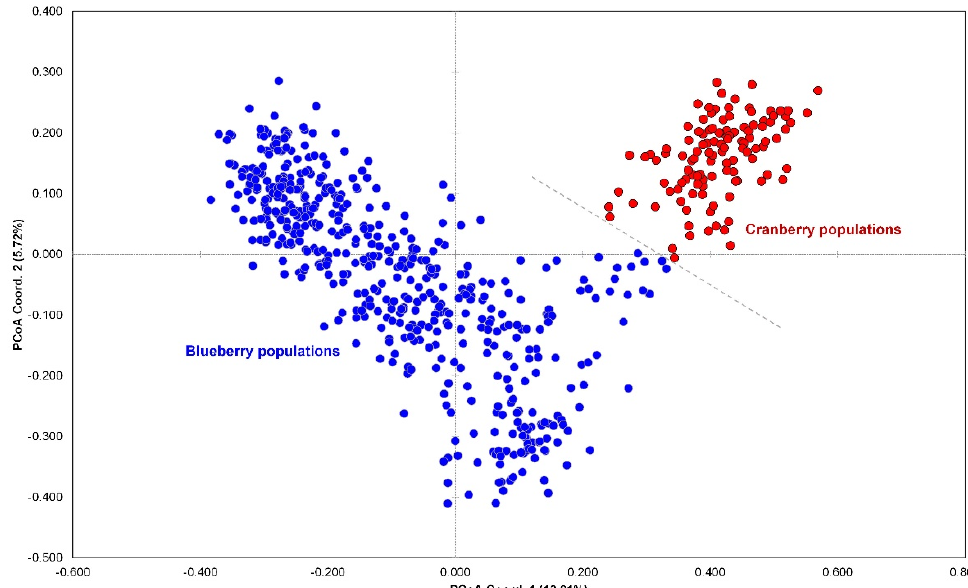
Figure 2. Principal coordinate analysis (PCoA) plotted using microsatellite data from 632 Dasineura oxycoccana individuals collected from 31 blueberry and cranberry populations from USA and Korea. The X-axis is coordinate 1, ranging from − 0.60 to 1.80, and the Y-axis is coordinate 2, ranging from − 0.50 to 0.40. Red circles correspond to cranberry populations, and blue circles correspond to blueberry